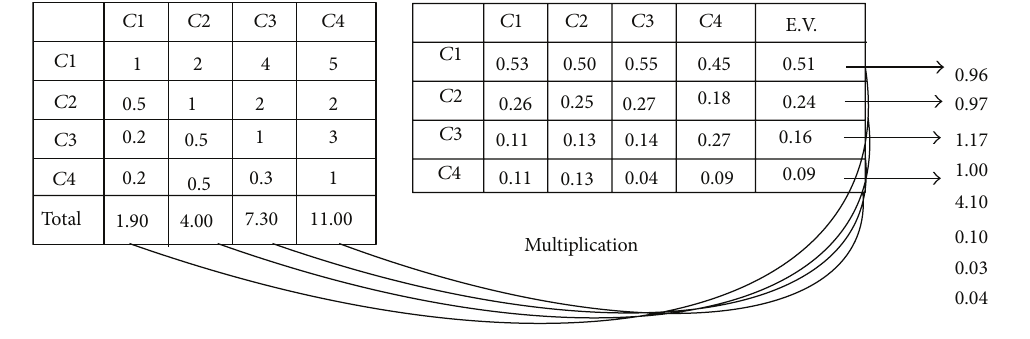
Figure 5: Finding eigenvalues.